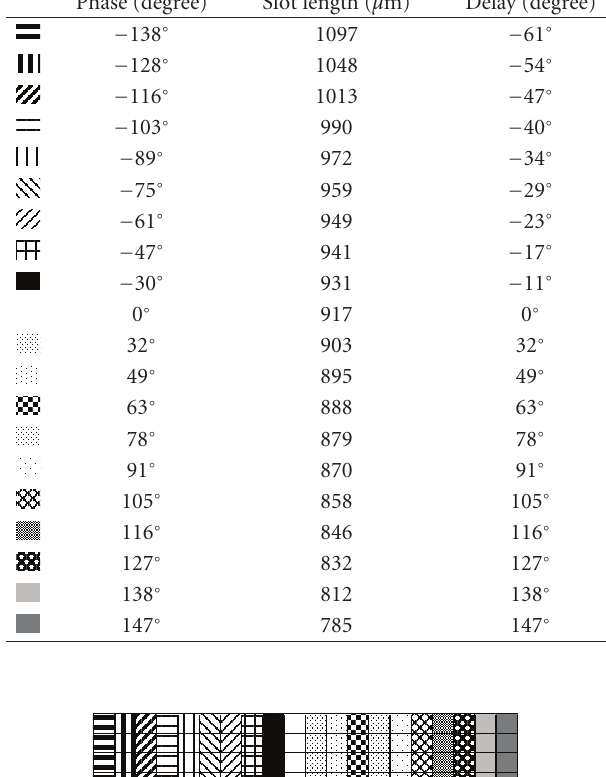
Table 1: Slot lengths, corresponding phase values, and phase delays of beam splitter. The patterns of the left most column of the table represent di ff erent columns of Figure 4.